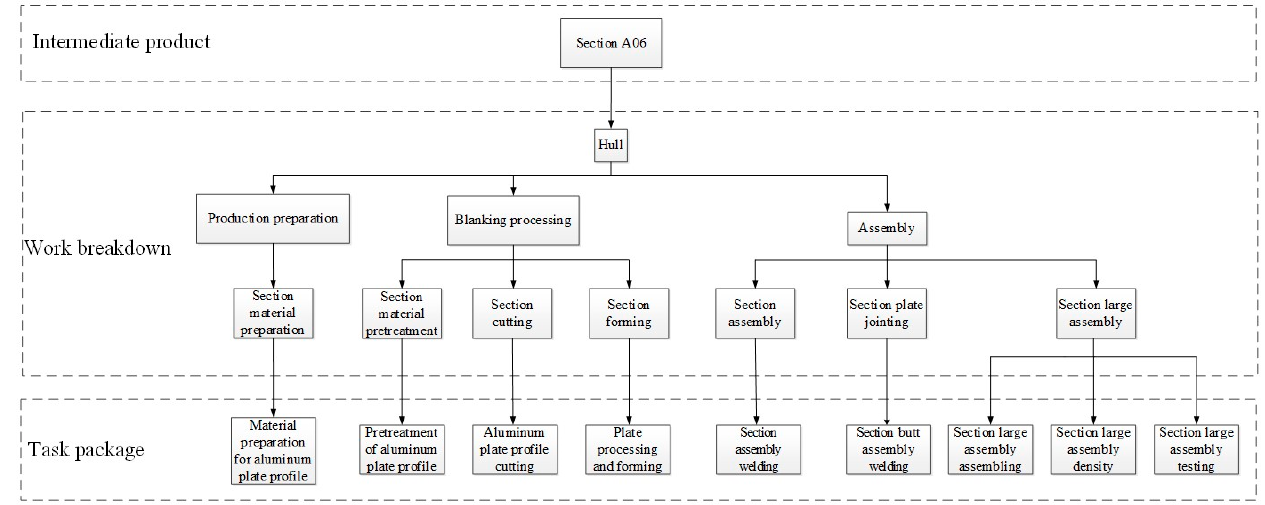
Figure 5. Composition of the section A06 task package.